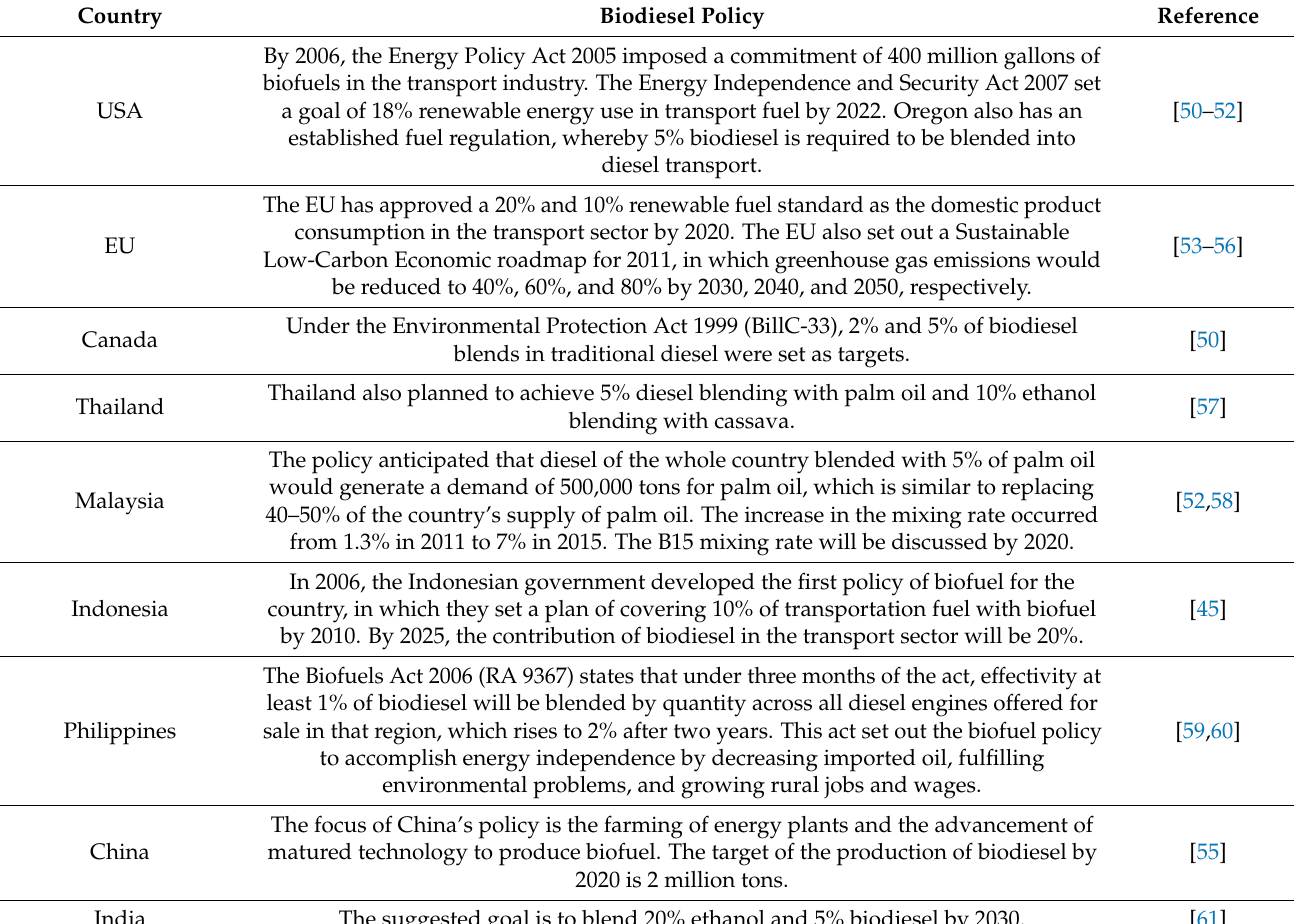
Table 1. Some countries’ policies about